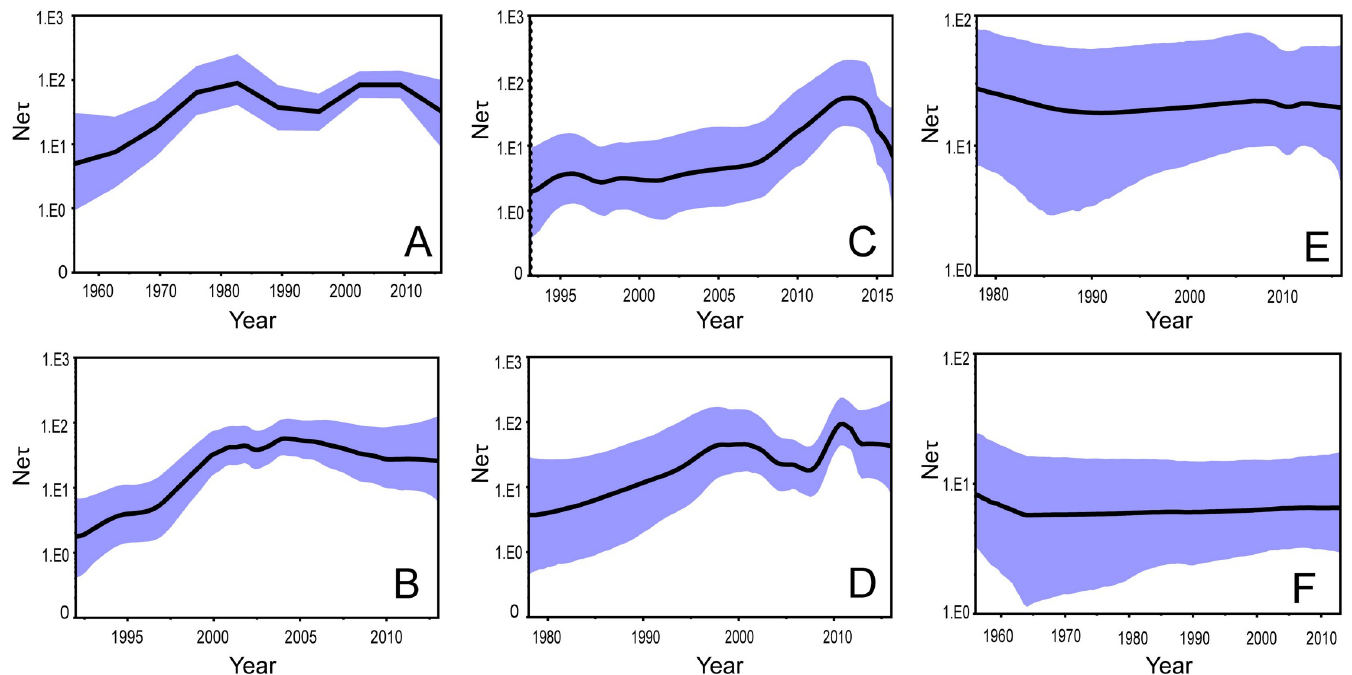
Fig 5. The demographical history of total DENV 4-I (A) and Clade I to V (B-F). The black line represents the median posterior value, and the blue area represents the 95% HPD intervals. The x-axis corresponds to time (years), while the y-axis is the product of the effective population size and the generation in years (N e τ